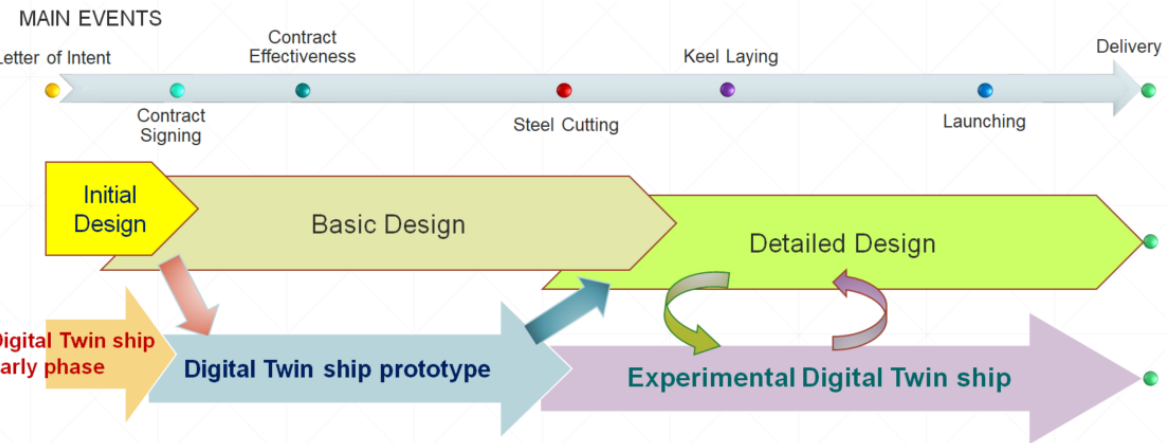
Figure 6. Digital Twin ship prototype.